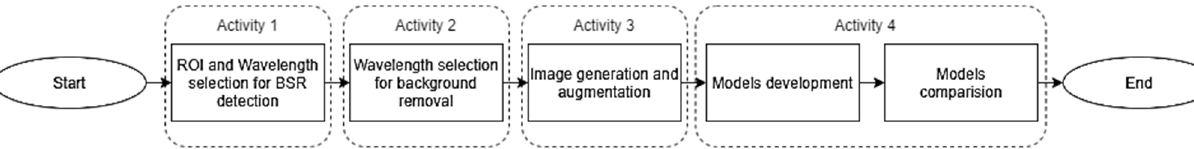
Figure 1. Flowchart of the process involved in this study.